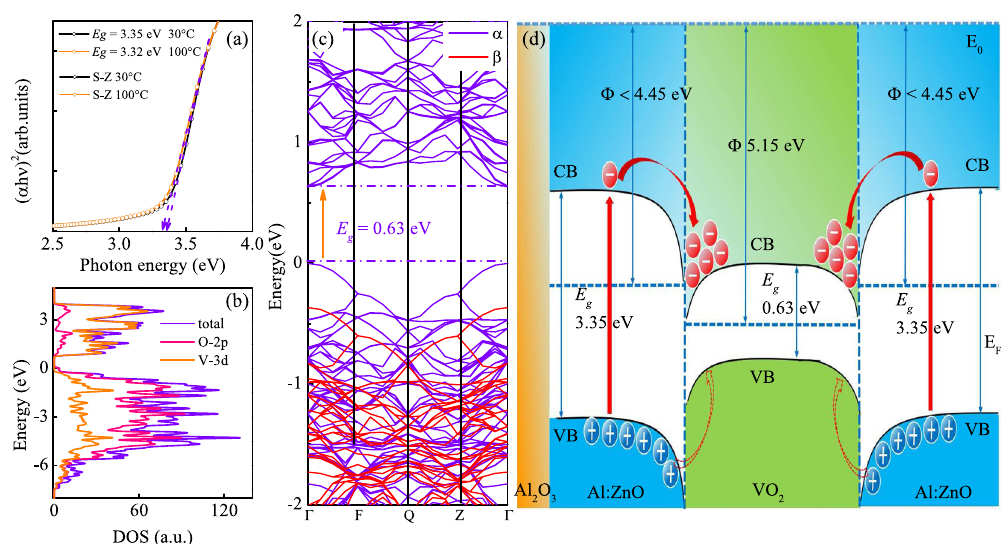
Figure 8. ( a ) The band gap of Al:ZnO obtained from the plot of ( α h ν ) 1/2 as a function of h ν . ( b , c ) The total and partial electron density of states (DOS) of the VO 2 film. ( d ) The energy band diagram of the n-n junction for the